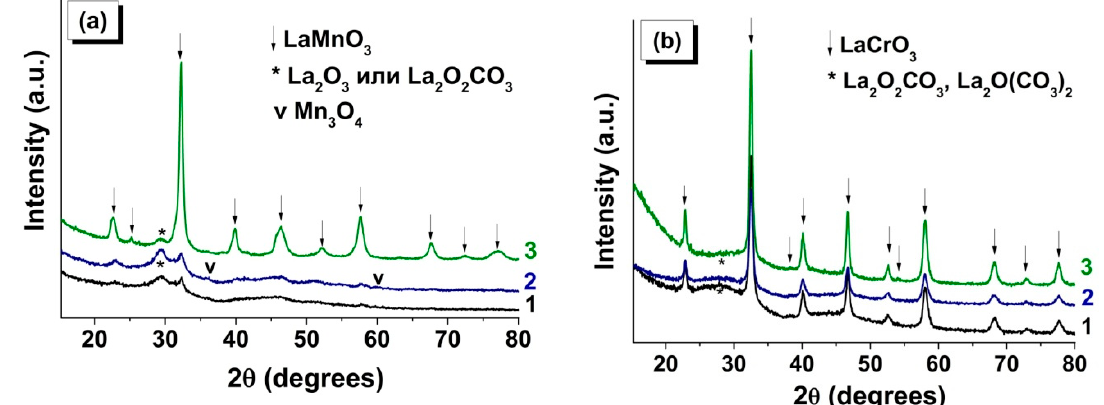
Figure 4. XRD of combustion products of ( a ) LaMn- and ( b ) LaCr-precursor for the following regimes: (1) solution combustion synthesis (SCS) (from solution), (2) volume combustion synthesis (VCS) (from powder), and (3) self-propagating high-temperature synthesis (SHS) (from pellet). Table 2. Phase composition and specific surface area for combustion products formed in the different regimes. The standard deviation is indicated in brackets.